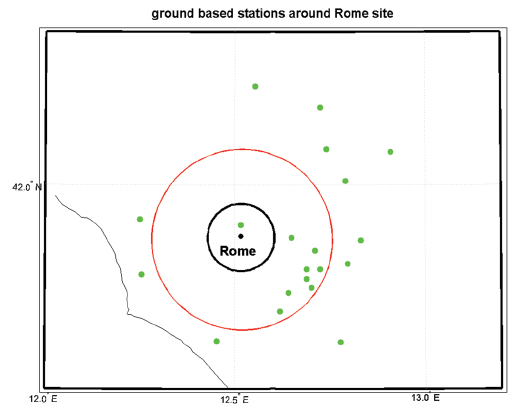
station located in the urban area has been excluded, Fig. 12).